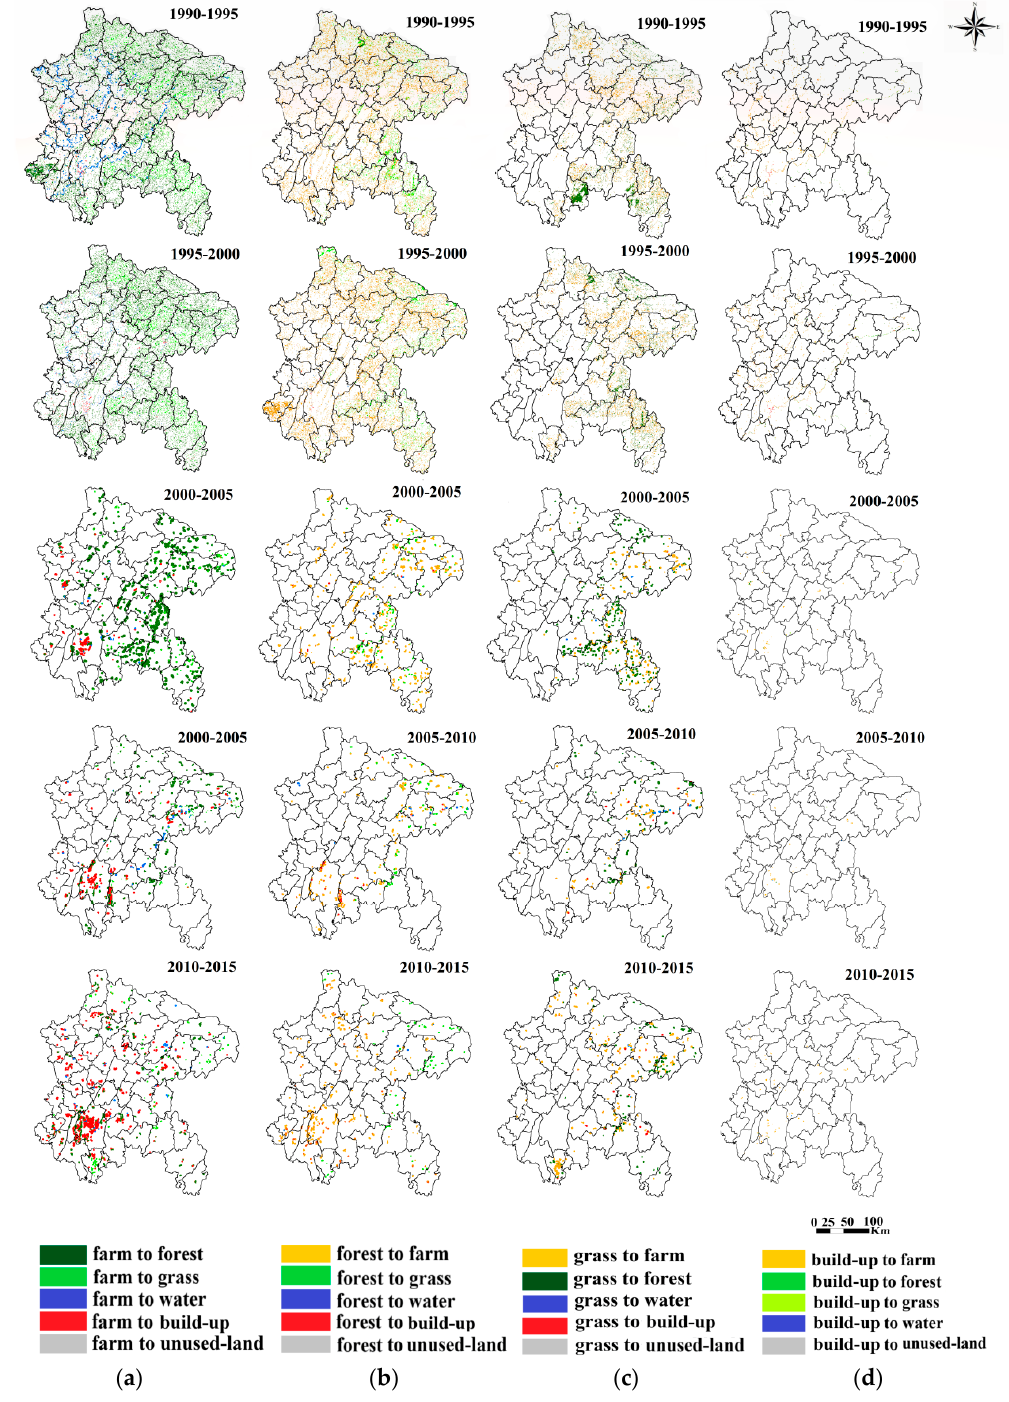
Figure 6. Transfer matrix map of land use: ( a ) Farmland; ( b ) Forestland; ( c ) Grassland; ( d ) Water land.